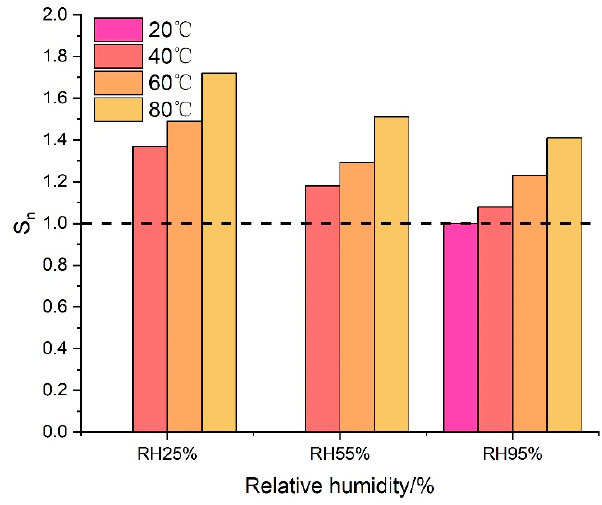
Figure 11. The influence of temperature and RH on Sn.